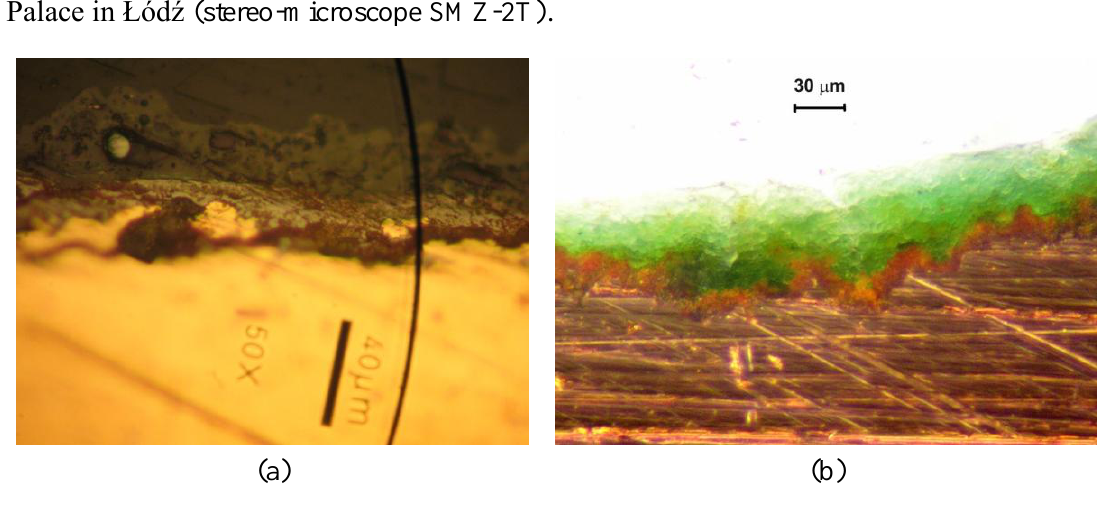
Figure 6. Sample SEM images of the deposit surface topography and composition of the sample from Wilanów Palace: (a) SE topographical mode; (b) BSE mode showing the chemical composition (dark areas contain lighter elements).